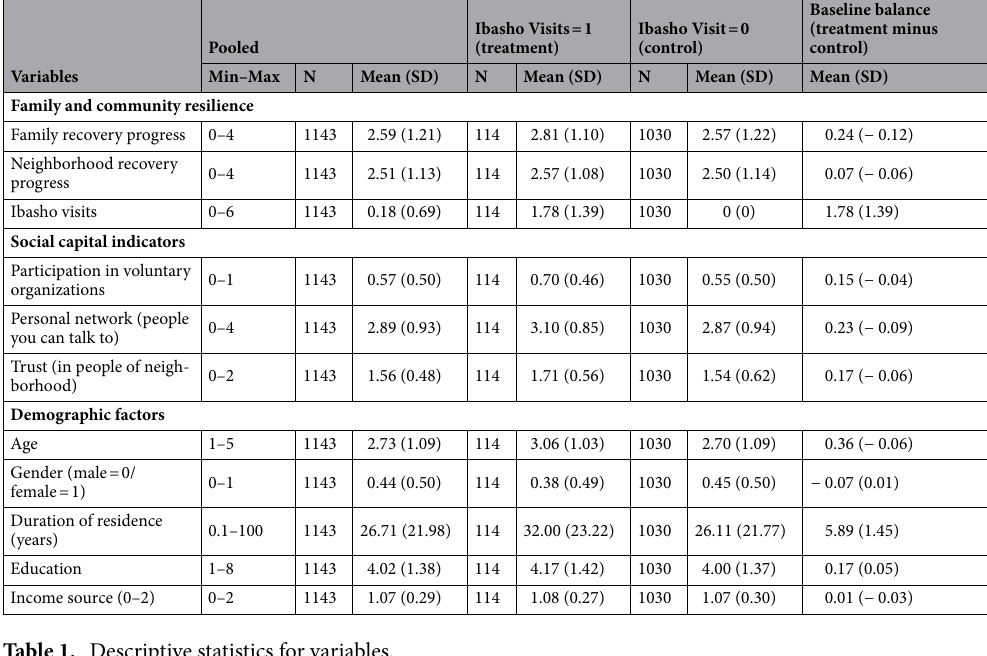
Table 1. Descriptive statistics for variables.